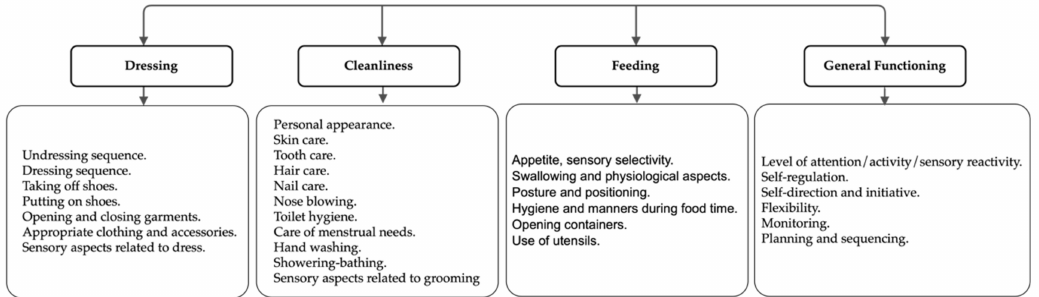
Figure 1. Initial categorization of the